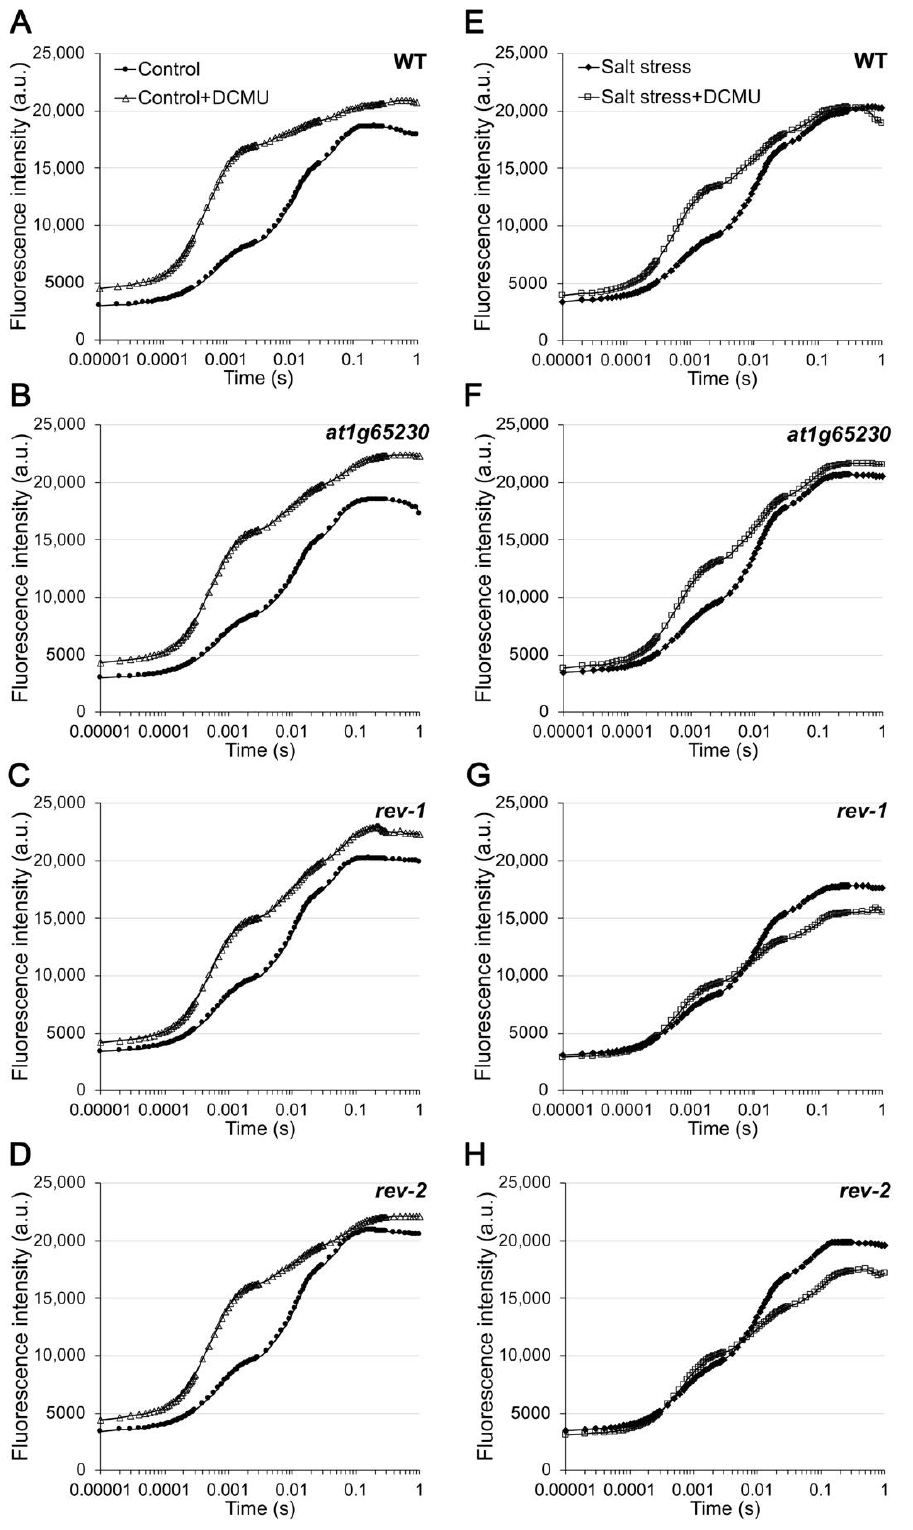
Figure 5. Chlorophyll fluorescence induction curve at 1 µ s to 1 s in the Arabidopsis wildtype (WT), at1g65230 mutant, and revertant line ( rev-1 and rev-2 ) determined after 10 days of treatment under control ( A – D ) and salt-stress ( E – H ) conditions. The trend lines show means of 6 replicates.